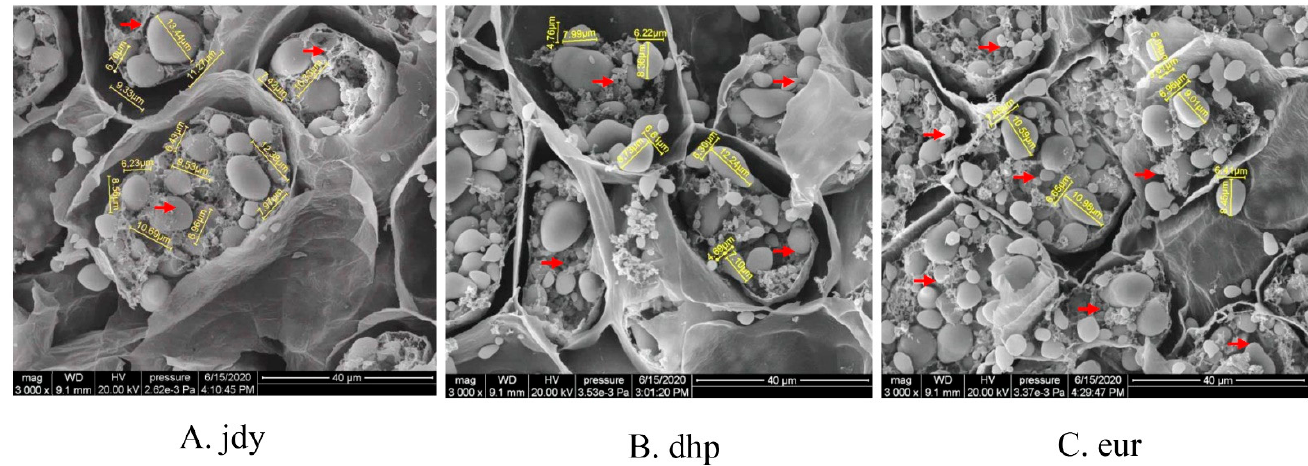
Figure 2. SEM images of starch granules of three chestnut cultivars. Each cultivar image is 3000×. Honeycomb-like holes are marked with red arrows.